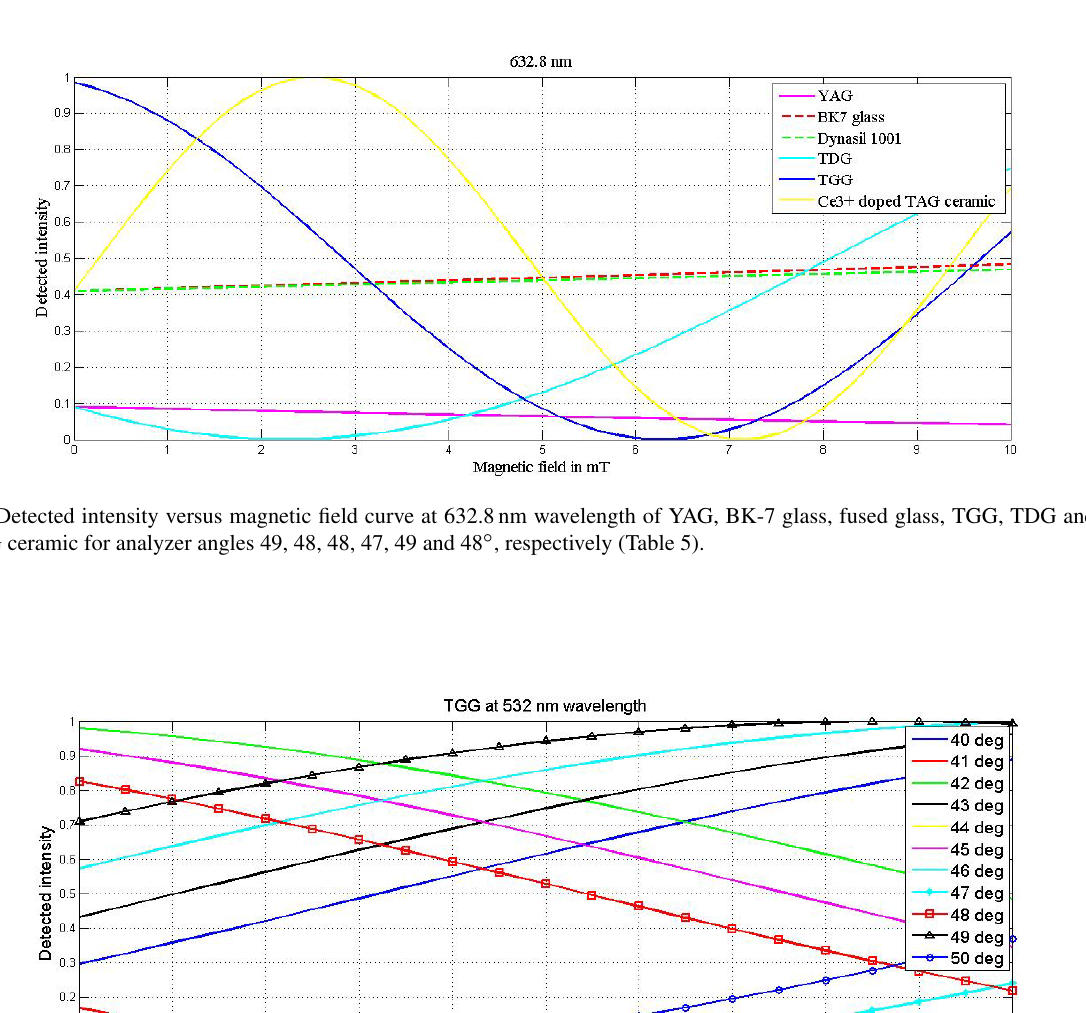
Table 3. Maximum sensitivity achieved at 532nm wavelength for magnetic field range 0–10mT (corresponding to Fig. 3).